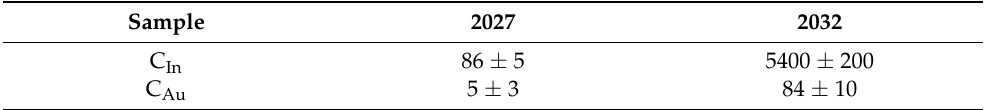
Table 24. Concentration of In (C In ) and Au (C Au ) in the crystals grown at 850 ◦ C using gas